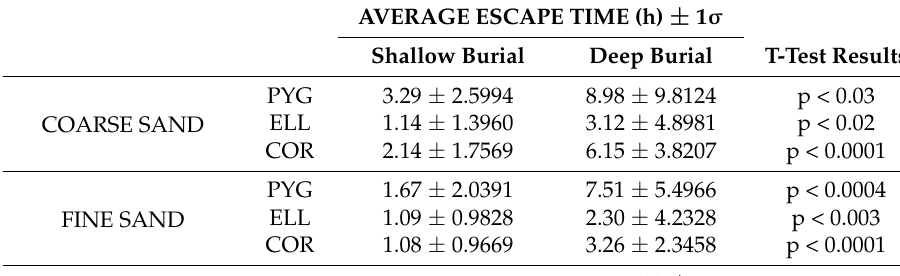
Table 7. Average Escape Time (time required to escape anastrophic burial by burrowing upward to the new sediment surface) for each test species expressed in hours. Shallow Burial—results for escape tests conducted from 1 to 5 cm burial depth. Deep Burial—results for escape tests conducted from 6 to 10 cm burial depth. Data shown here compare escape performance at shallow versus deep burial depth for each test species. Top half of the table compares average performance at constant grain size for shallow versus deep burial. Bottom half of the table compares average performance at constant depth in coarse versus fine sand. σ —standard deviation. Coarse sand: 0 Φ ≥ grain size ≥ 1 Φ . Fine sand: 2 Φ ≥